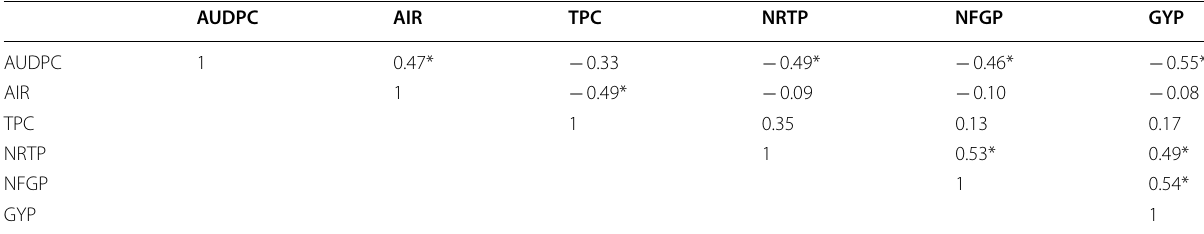
Table 5 Correlation analysis of the observed